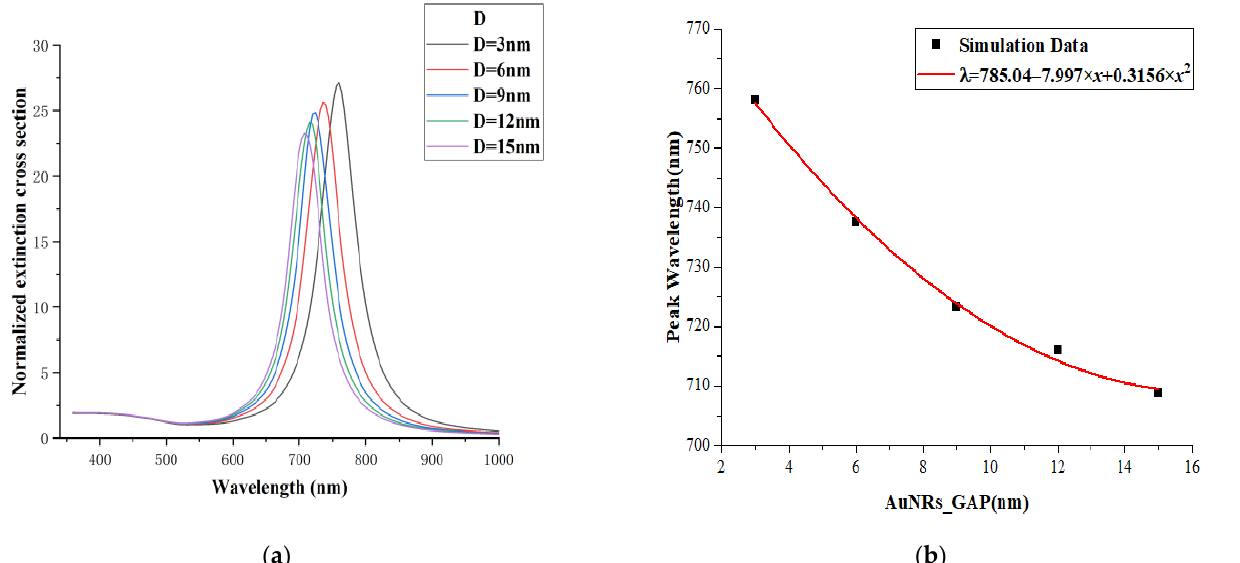
Figure 5. ( a ) The extinction cross-section of the gold nanorod dimer in the longitudinal structure; ( b ) the relationship between the arrangement spacing of the gold nanorod dimer and the resonance peak wavelength.